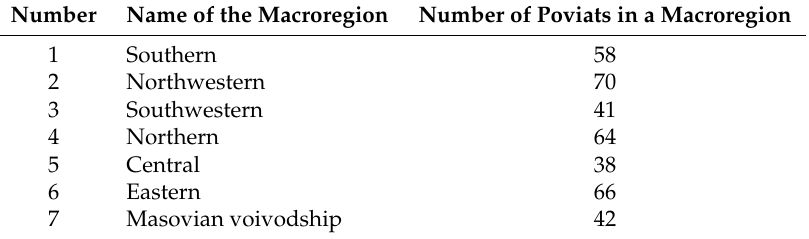
Figure 1. Macroregions in Poland (NUTS-1. 2018). Source: Statistics Poland. Table 1. Structure of Polish macroregions including